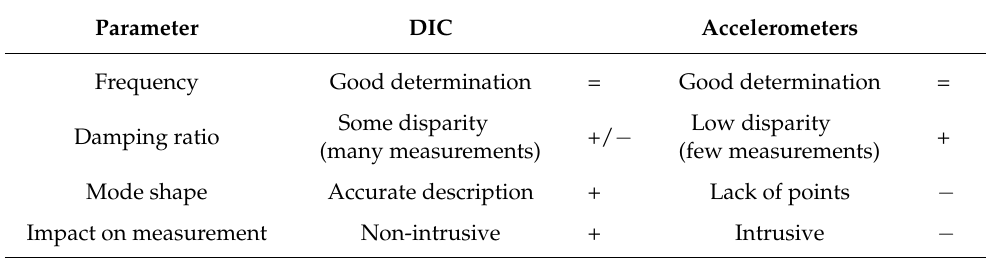
Table 6. Comparison between the DIC measurements and